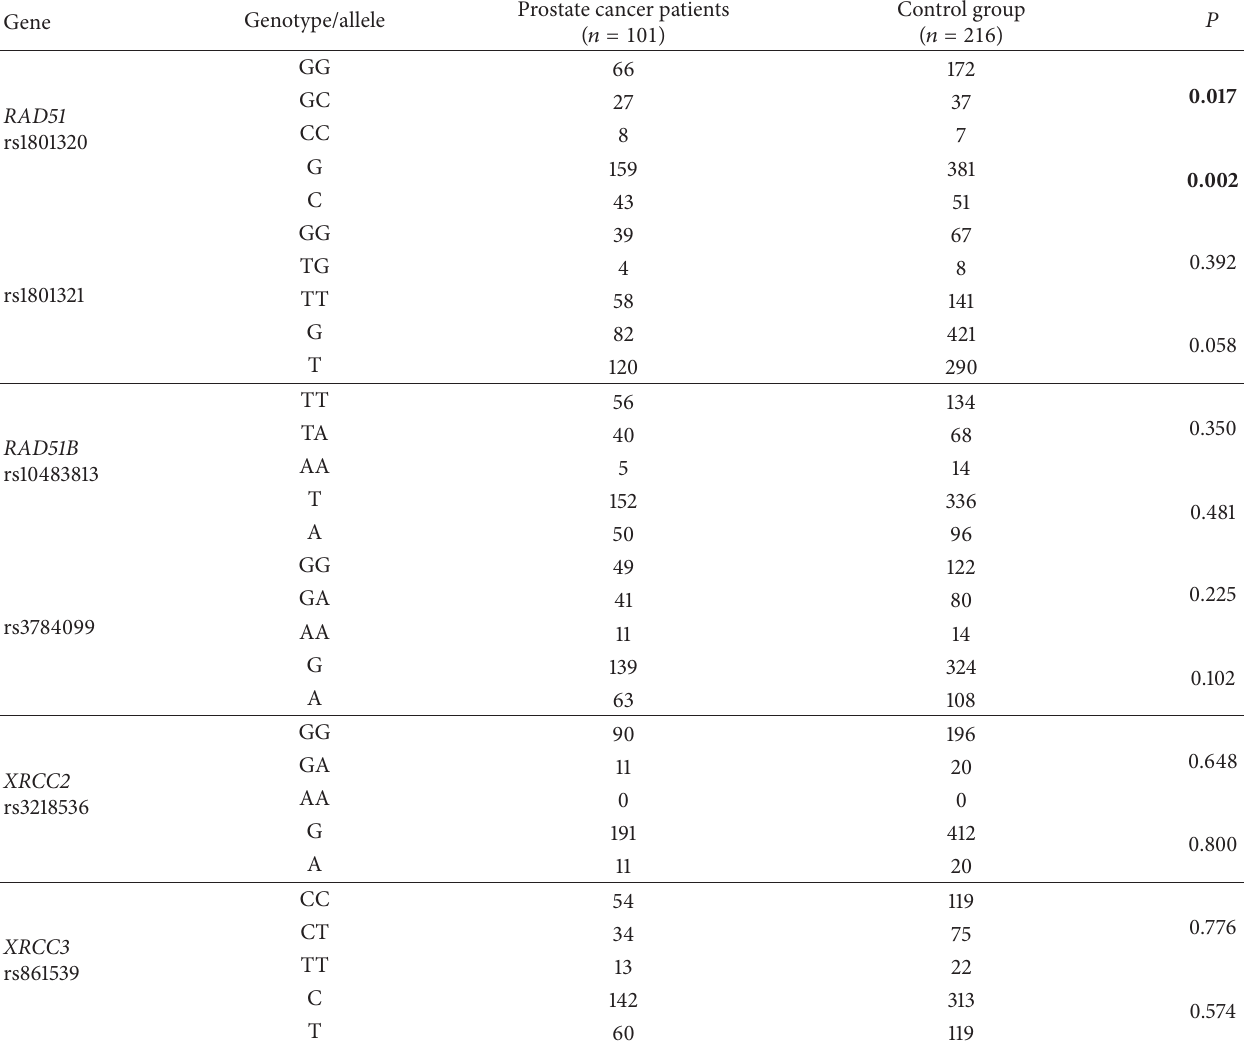
Table 4: Distribution of genotypes and allele frequency in the RAD51 , RAD51B , XRCC2 , and XRCC3 loci among prostate cancer patients. Gene